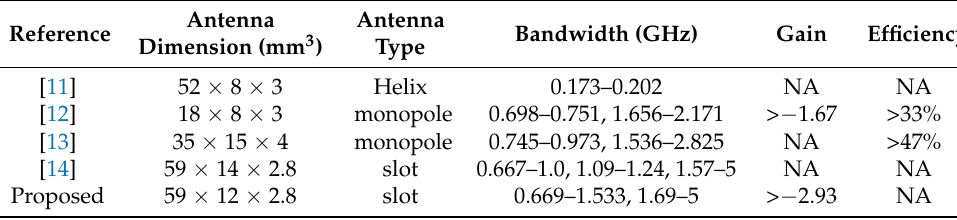
Table 2. Comparison of the proposed antenna with antennas in published literatures.